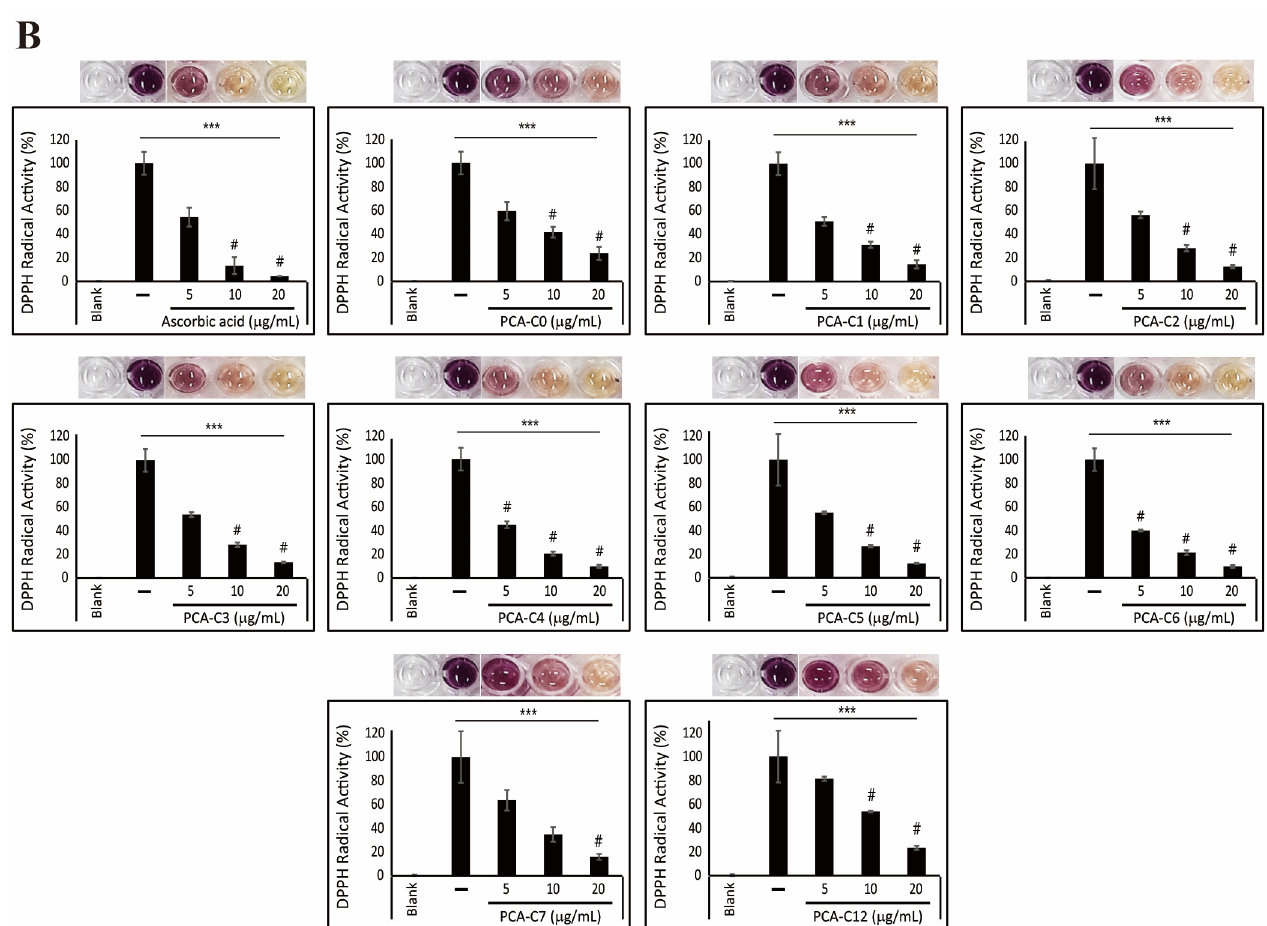
Figure 3. PCA derivatives have an antioxidant effect on HS68 fibroblast cells. ( A ) The inhibition of HS68 cell proliferation after treatment with an increased PCA-C(X) concentration for 24 h was shown by cell viability. The data represent three independent tests. # p < 0.001 versus control. *** p < 0.001 (ANOVA test). ( B ) The antioxidant effect of the PCA derivatives was confirmed by measuring DPPH radical activity. The pictures show that the color of the culture medium was reduced by PCA-C(X). The data are representative of three independent experiments. # p < 0.001 versus control. *** p < 0.001 (ANOVA